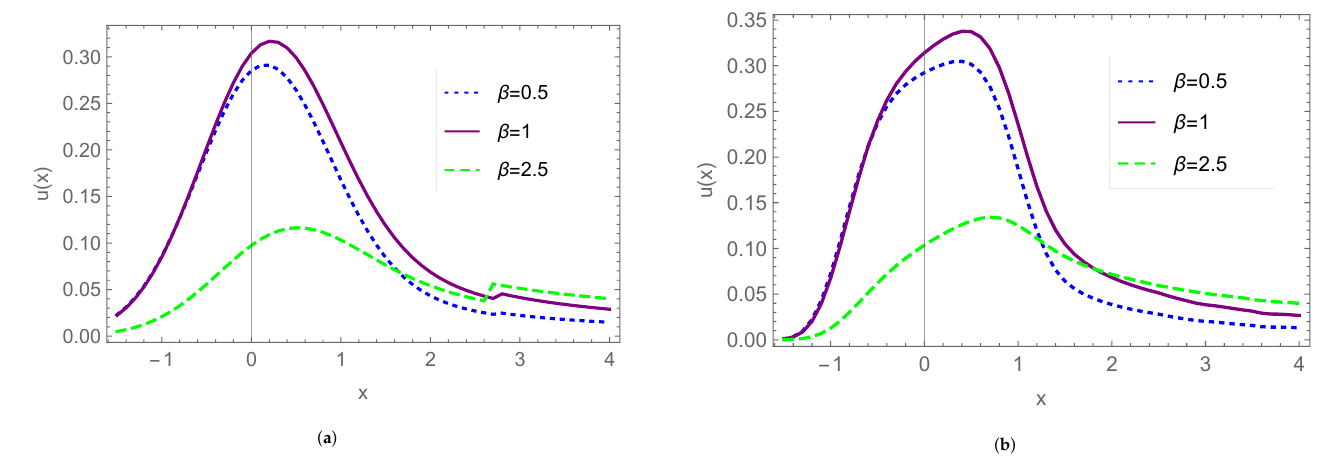
and f ( x ) Gaussian or super-Gaussian function. ( a ) f ( x ) = e − x 2 ; ( b ) 3